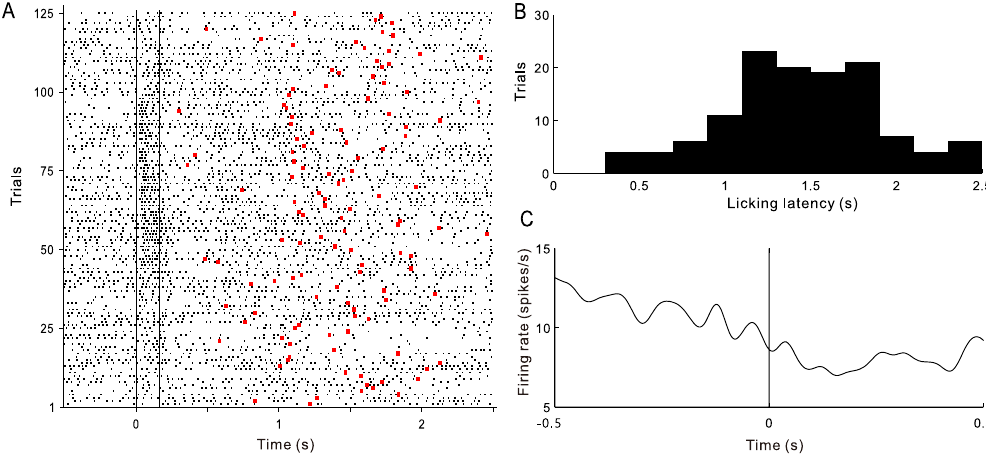
Figure 9. Effect of licking response on the spike activity of the auditory neuron. ( A ) Raster plot of an example unit in an active session. Red dot represents the the time of first licking. ( B ) Distribution of the latency of the first licking. ( C ) Peri-licking peri-stimulus time histogram (PSTH). Vertical line represents the time of the first